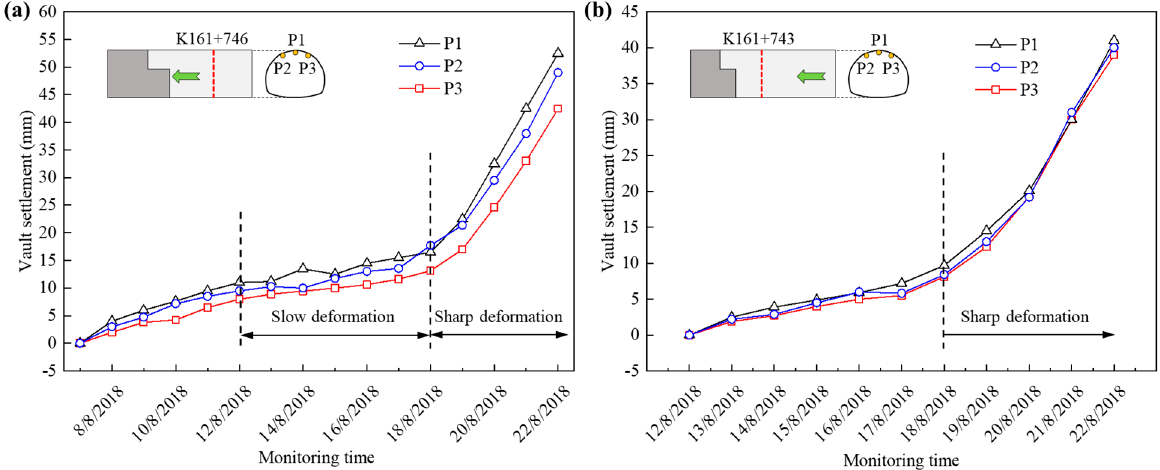
Figure 10. Vault settlement before collapse: ( a ) K161 + 746 section; ( b ) K161 + 743 section. Although the tunnel was reinforced by the above measures, it was in rainy season with frequent rainfall, and there was still the possibility of collapse again. The possible causes of collapse were as follows: (1) The soil at this location still had a high water content after the erosive action of the disturbance that caused this collapse. (2) After the collapse, the soil in the tunnel entrance section became looser than before. (3) The above reinforcement measures were not necessarily the most suitable treatment measures for this collapse and were subject to verification. In order to grasp the displacement changes of surrounding rock during the secondary excavation and the deformation characteristics of the entrance slope, displacement test elements were placed inside the tunnel and inclinometer tubes were installed inside the slope. Inclinometer tubes were laid at the outer edge of the interceptor ditch and inserted vertically downward into the soil layer. The tunnel displacement monitoring data of the monitoring section ZK161 + 729 was selected for reinforcement effect analysis; the test elements and monitoring lines of this section are shown in Figure